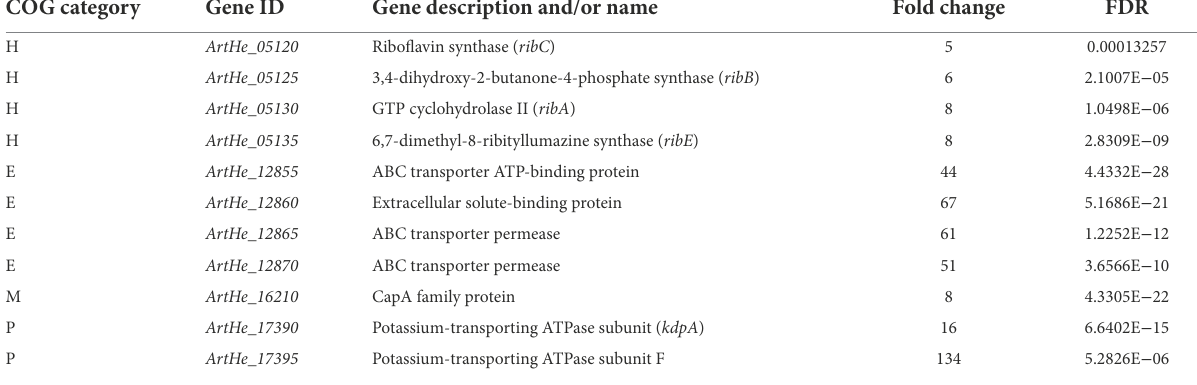
TABLE 6 DEGs in PEG10 vs.